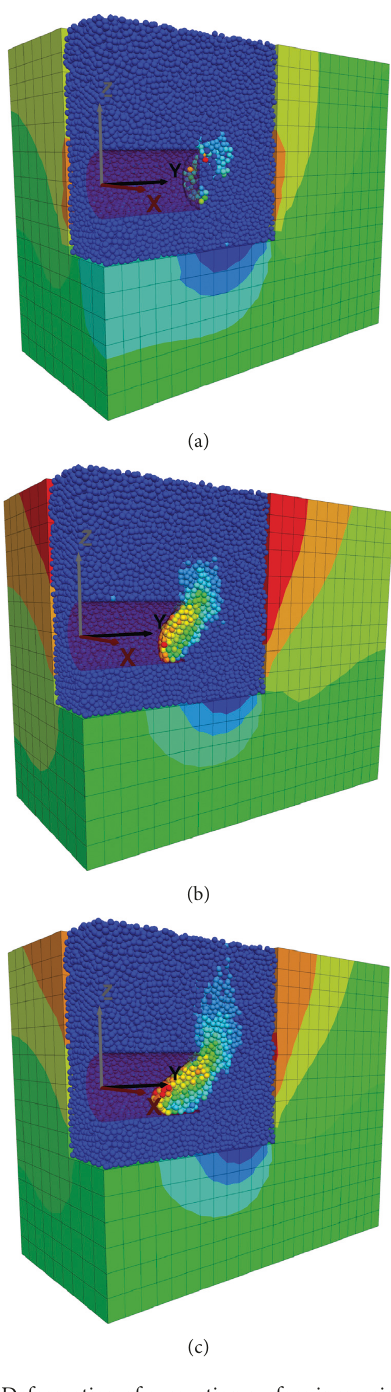
Figure 14: Deformation of excavation surface increasing with time without